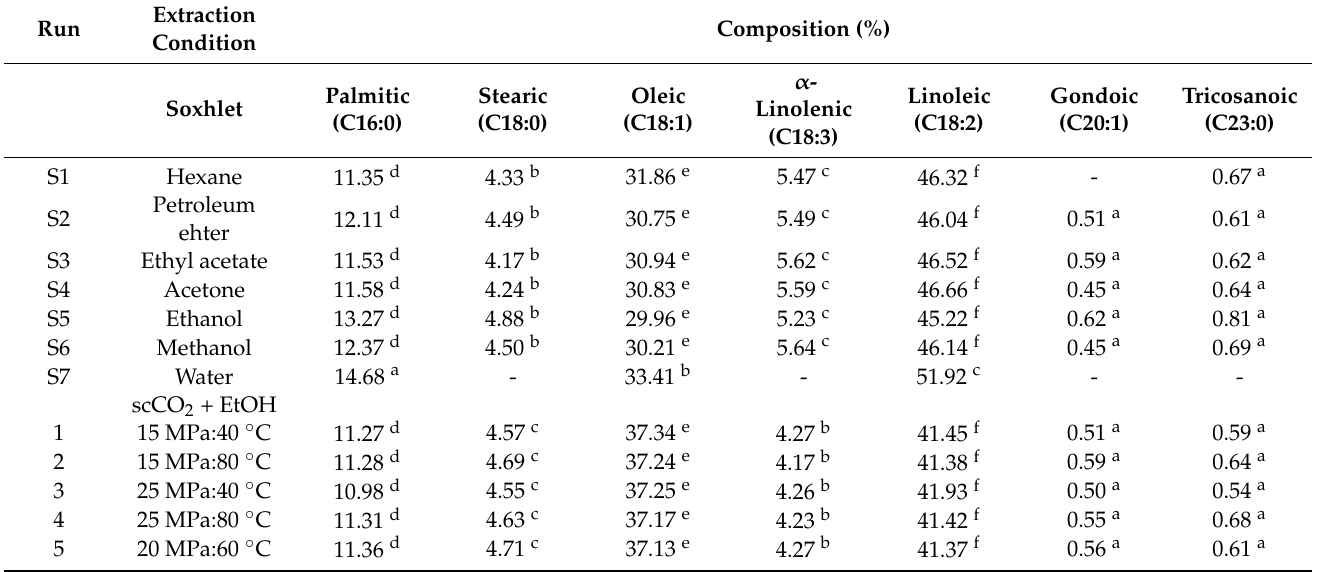
Table 3. Fatty acid composition of fermented soybean extracts obtained by Soxhlet extraction using different solvents and scCO 2 + EtOH under different